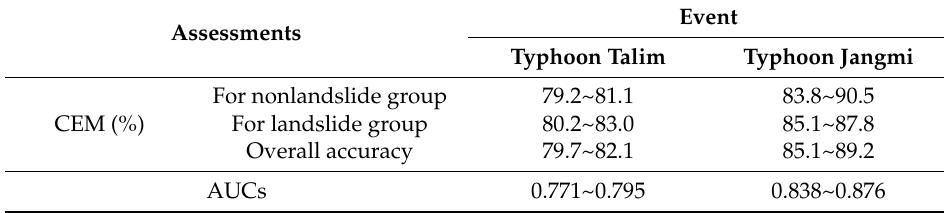
Table 5. The performance of the landslide susceptibility model. CEM = classification error matrix; AUC = area under a receiver operating characteristic